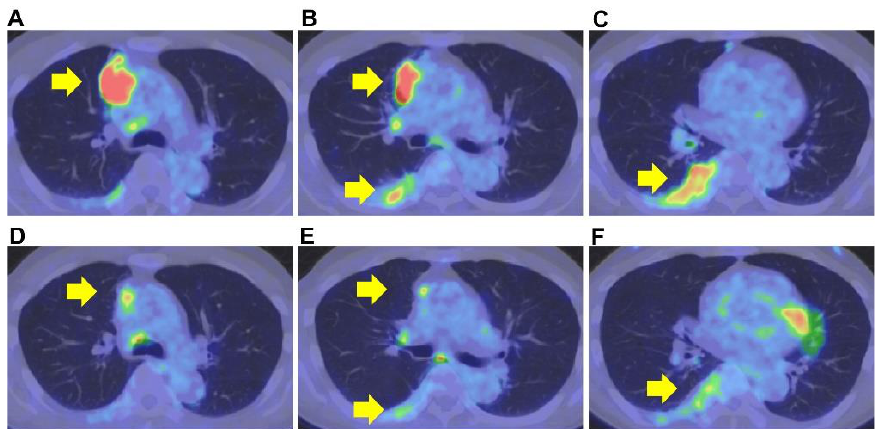
Figure 4. Positron emission tomography – computed tomography . Before therapy, the primary tu- Figure 4. Positron emission tomography–computed tomography. Before therapy, the primary mor ’ s positron emission tomography – computed tomography showed high 18 F-fluorodeoxyglucose tumor’s positron emission tomography–computed tomography showed high 18 F-fluorodeoxyglucose accumulation and a maximum standardized uptake value of 10.95 ( A – C ). After therapy, the primary accumulation and a maximum standardized uptake value of 10.95 ( A – C ). After therapy, the primary tumor ’ s positron emission tomography – computed tomography showed a maximum standardized tumor’s positron emission tomography–computed tomography showed a maximum standardized uptake value of 4.5 ( D – F ). uptake value of 4.5 ( D – F